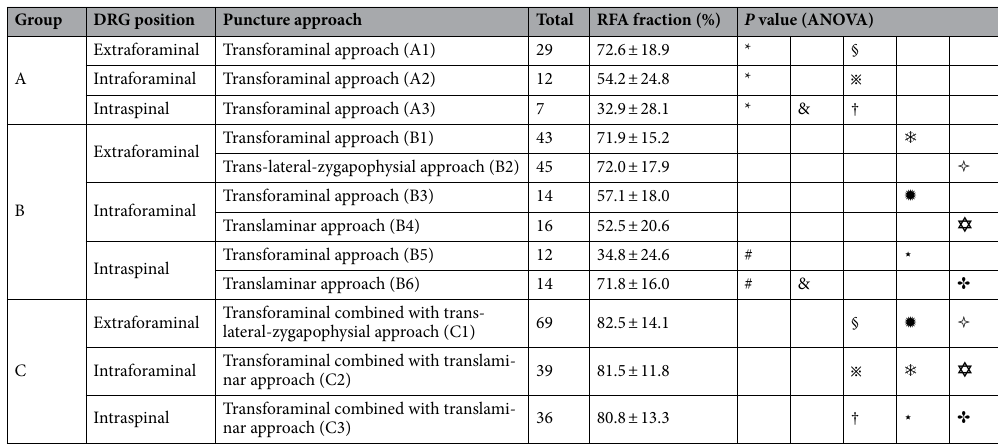
Table 2. RFA fraction of three groups. * P < 0.05 during comparison between DRG positions within Group A; # P < 0.05 during comparison between puncture approaches within DRG position subgroups in Group B; & P < 0.05 during comparison between puncture approaches within DRG position subgroups of Groups A and B; §, ,† P < 0.05 during comparison between puncture approaches within DRG position subgroups of Groups A and C; ❄ , ✧ , ✺ , ✡ , ⋆ , ✢ P < 0.05 during comparison between puncture approaches within DRG position ※ subgroups of Groups B and